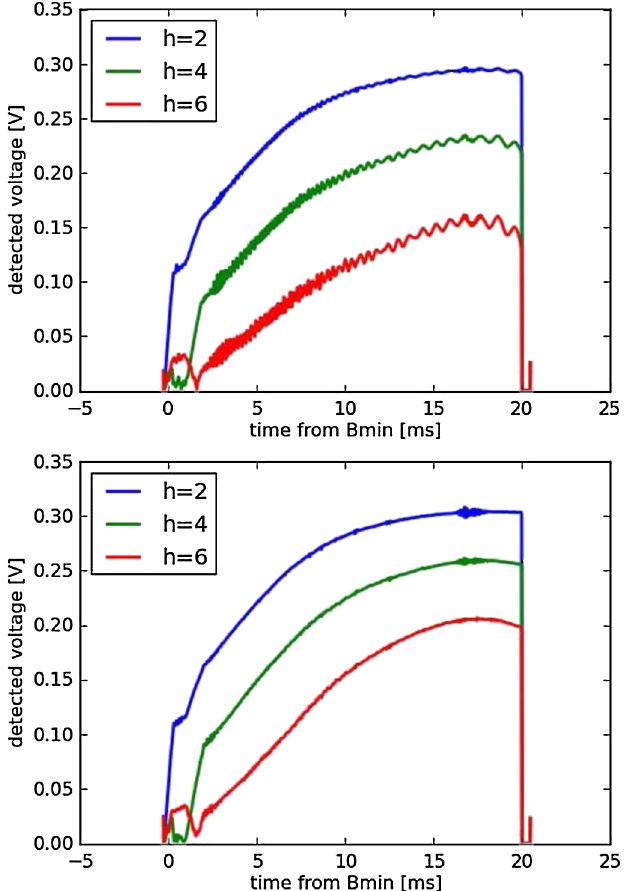
FIG. 21. Harmonic components of the WCM beam signals (top) without and (bottom) with the feedforward. The oscillation of harmonic components is much